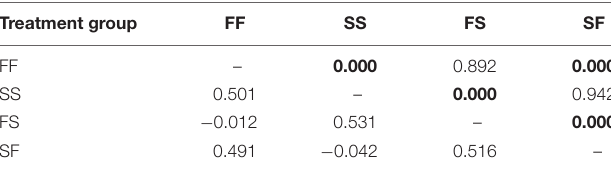
Bold p-values indicate statistical significance. FF, flat to flat; FS, flat to slope; SF, slope to flat; SS, slope to